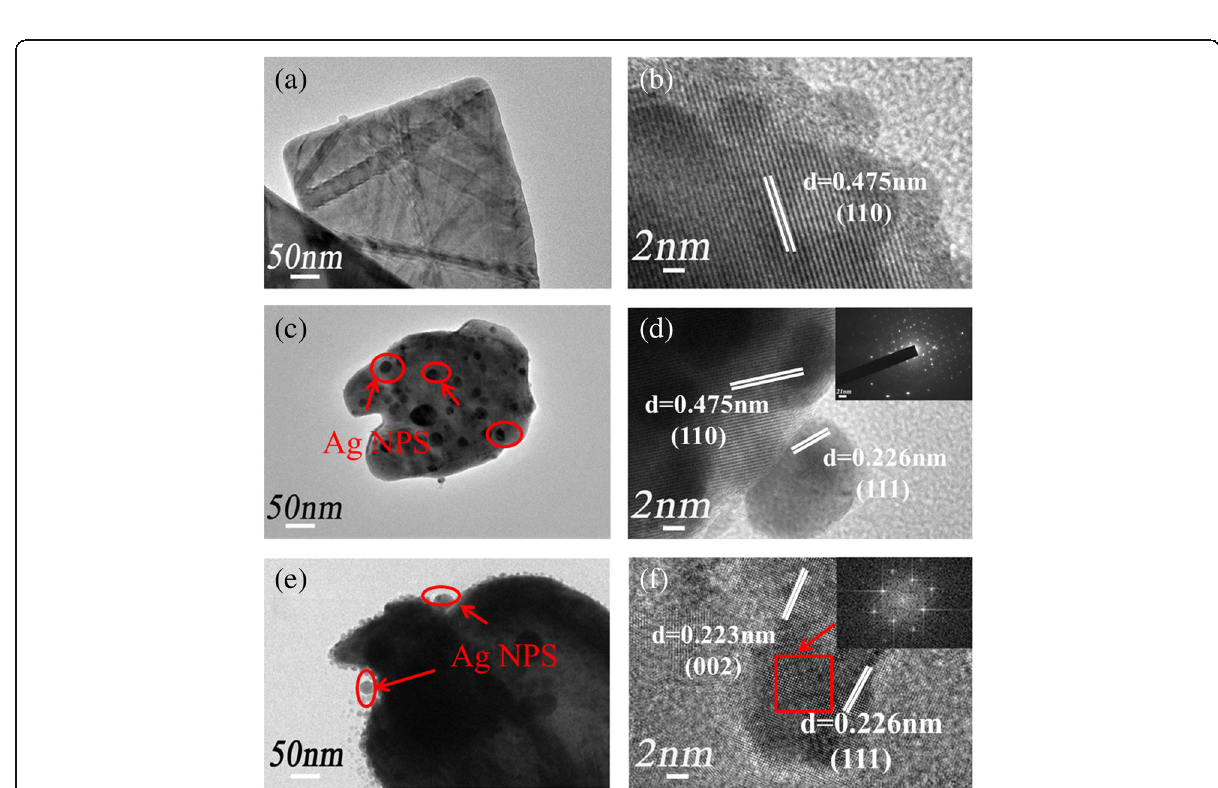
Fig. 4 TEM images of a pure BiVO 4 , c Ag/BiVO 4 , and e Ag/BiV 0.9925 Mo 0.0075 O 4 and b , d , and f high-magnification images of a , c , and e ,